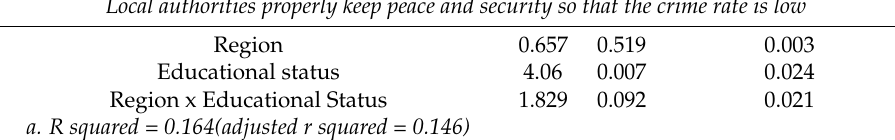
Figure 4. Households’ views of power relations based on their educational status; source: survey data by the authors (2011/12).